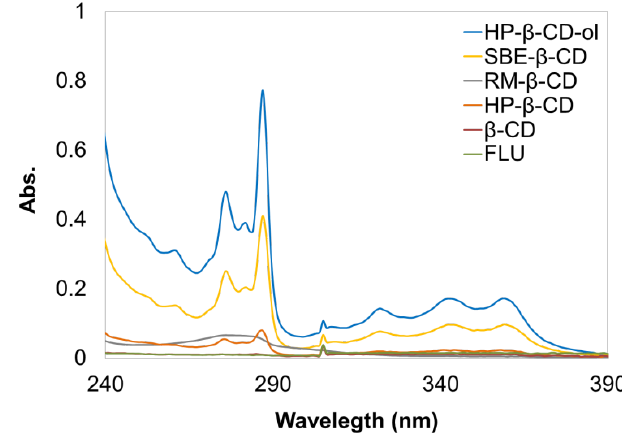
Figure 4. UV-spectra of FT in the presence of 1 mM β-CD, HP-β-CD, RM-β-CD, SBE-β-CD, and HP-β-CD-ol in water at 25 °C.